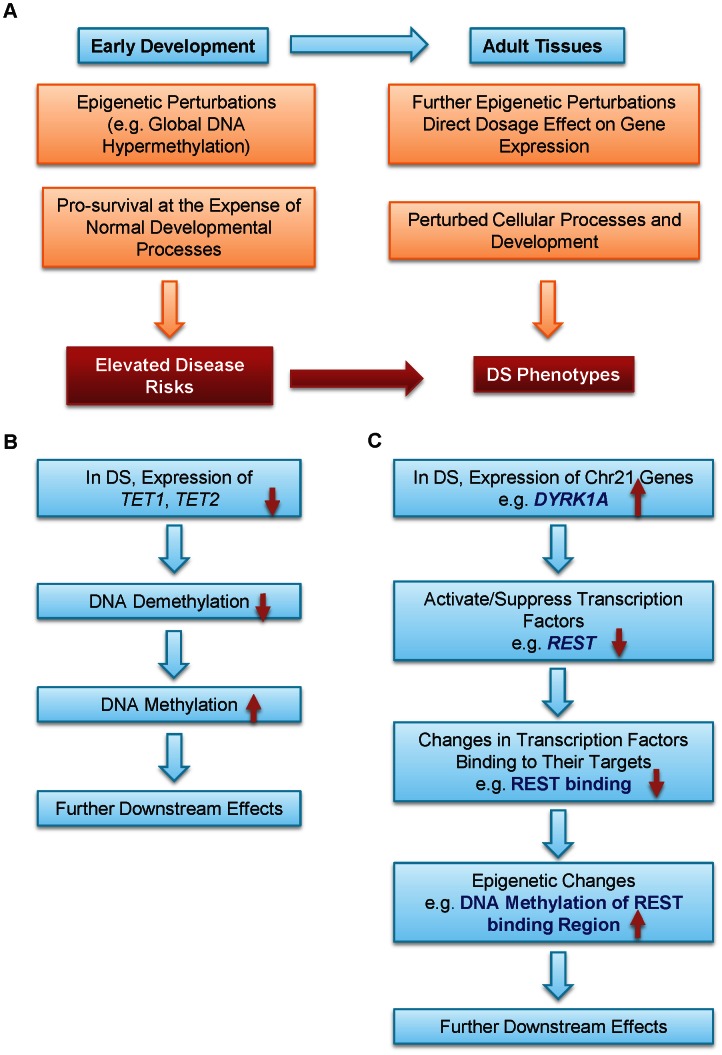
A model for epigenetic contributions to DS phenotypes.(A) Epigenetic perturbations such as global DNA methylation are early events in development. Consequently, multiple different adult tissues may share common patterns of epigenetic perturbations. Such early perturbations in response to an extra chr21 may confer certain survival advantages, at the expense of some normal developmental processes, which may lead to elevated disease risks. Further epigenetic perturbations and other abnormalities may alter cellular processes and development. Collectively, these perturbations may help contribution to many DS phenotypes with different penetrance and expressivity. Hypermethylation in DS may be caused by (B) down-regulation of the TET family genes and (C) down-regulation of REST by DYRK1A located on chr21.